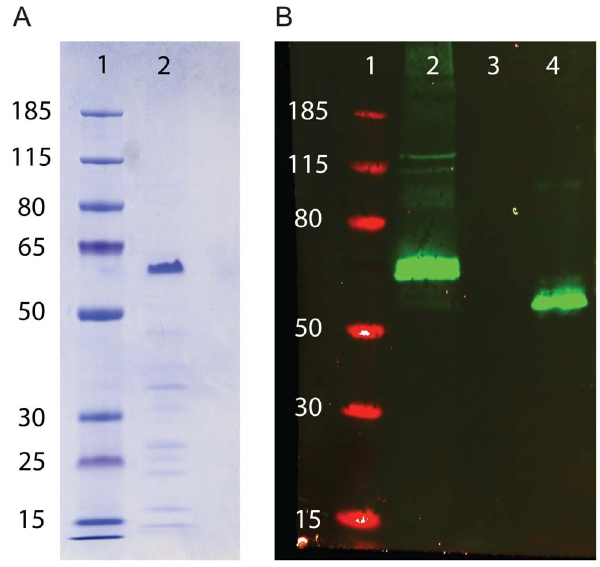
Figure 2. Analysis of purified MSP-1-BBM protein by SDS-PAGE and Western blotting. A. Coomassie-stained gel of purified MSP-1- BBM protein produced in T. thermophila . Lane 1. Molecular weight markers. Lane 2. 0.5 m g purified MSP-1-BBM protein. B. Western blot of MSP-1-BBM protein and MSP-1 hybrid probed with with mAb 12.2, (specific for repeat sequences present in the K1 serotype of MSP-1 Block 2). Lane 1. Molecular weight markers. Lane 2. 0.5 m g of Tetrahymena - derived MSP-1-BBM protein. Lane 3. Negative control. Lane 4. 0.5 m g MSP-1 Block 2 hybrid protein [30] (positive control).